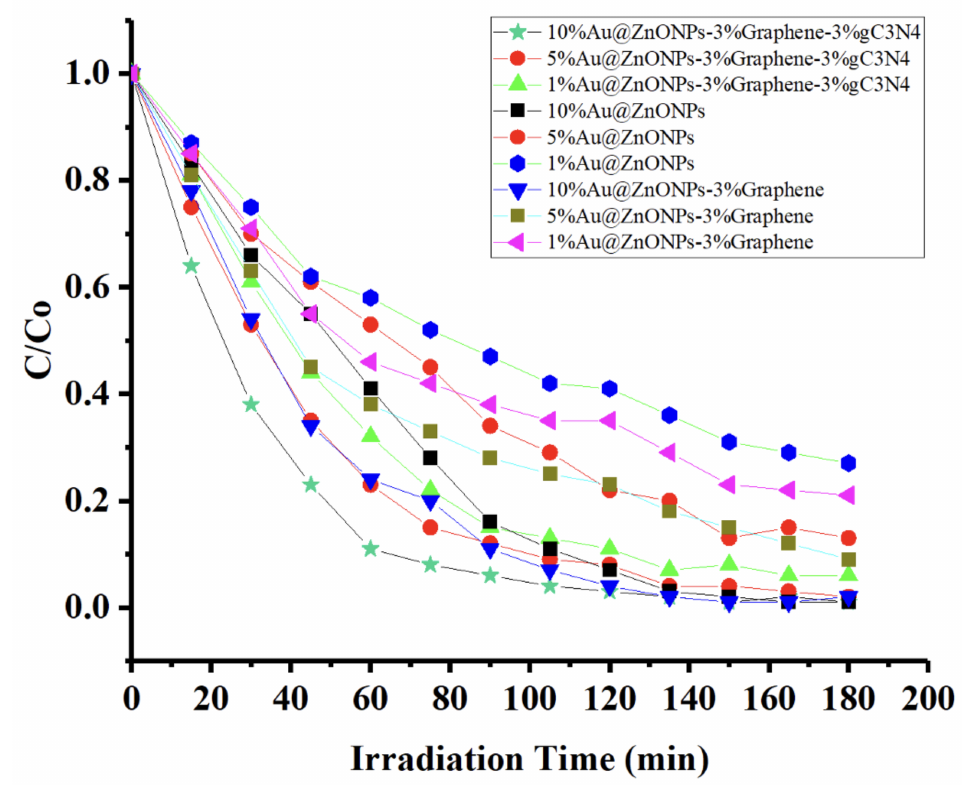
Figure 7. Photodegradation rate of CFX as a function of time, using the different catalysts evaluated.